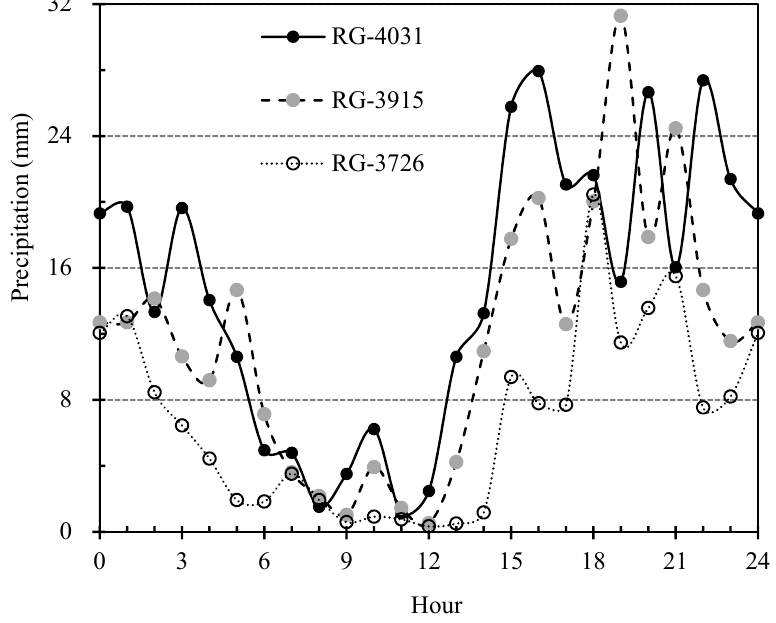
Figure 5. Diurnal variation of precipitation in the rainy season of 2013.